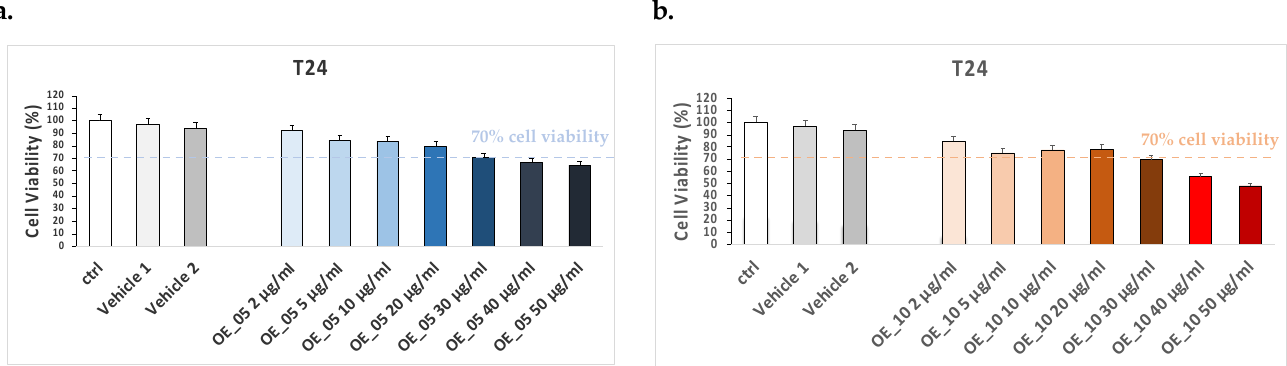
Figure 3. CaCo-2 cell viability evaluated by MTT assay after 24 h of pre-treatment with olive oil compound extracts OE_05 and OE_10 at different doses ranging from 2 to 50 µ g/mL. ( a ) Vehicle 1 represents the DMSO concentration of OE_05 or OE_10 2 µ g/mL solution. ( b ) Vehicle 2 represents DMSO concentration of OE_05 or OE_10 50 µ g/mL solution. Ctrl represents untreated cells. Data are given as means ± SD, representative of three independent experiments with at least three technical replicates each time. To evaluate the antioxidant properties of EVOO extracts, we triggered CaCo-2 cells with the oxidoreductase enzyme glucose oxidase (GO), which catalyzes the oxidation of glucose in hydrogen peroxide (H 2 O 2 ), a known oxidative mediator. After pre-treating CaCo-2 cells with 20 µ g/mL OE_05 , OE_10 , or OE_15 , we assessed an AmplexRed assay to measure the levels of H 2 O 2 produced over 1 h of GO 0.5 U/mL treatment. As depicted in Figure 4a, GO exposure induced higher levels of H 2 O 2 production at all selected timepoints. Even though OE_05 and OE_10 did not completely abrogate the H 2 O 2 production com- pared to control cells, they could reduce the levels of H 2 O 2 induced by GO. To test whether the reduction of the H 2 O 2 production found in CaCo-2 cells was due to the ability of